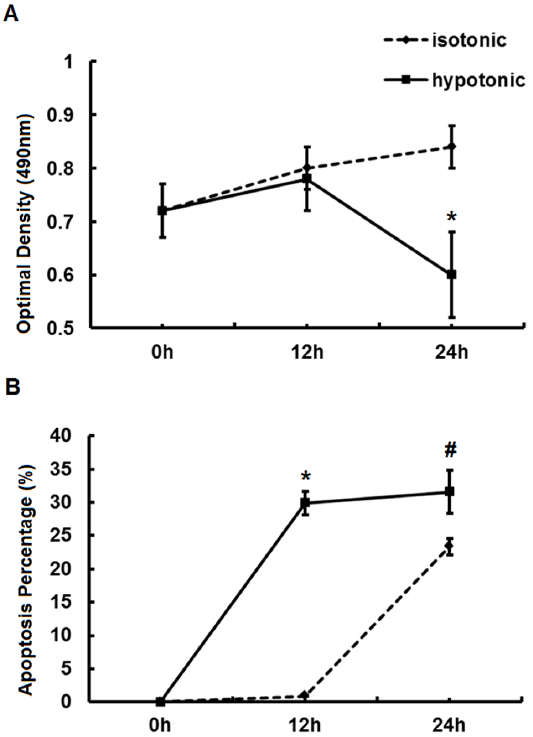
Figure 1. Proliferation and apoptosis assessed by MTT assay and FACS analysis respectively. (A) MTT assay assessing the proliferation of IMCD cells exposed to hypotonic or isotonic stress for 0 h, 12 h and 24 h. (B) FACS assessing the apoptosis percentage of IMCD cells exposed to hypotonic or isotonic stress for 0 h, 12 h and 24 h. *, P , 0.05 compared with isotonic group. # , P , 0.05 compared with isotonic group. Error bars represent the standard deviations based on three independent